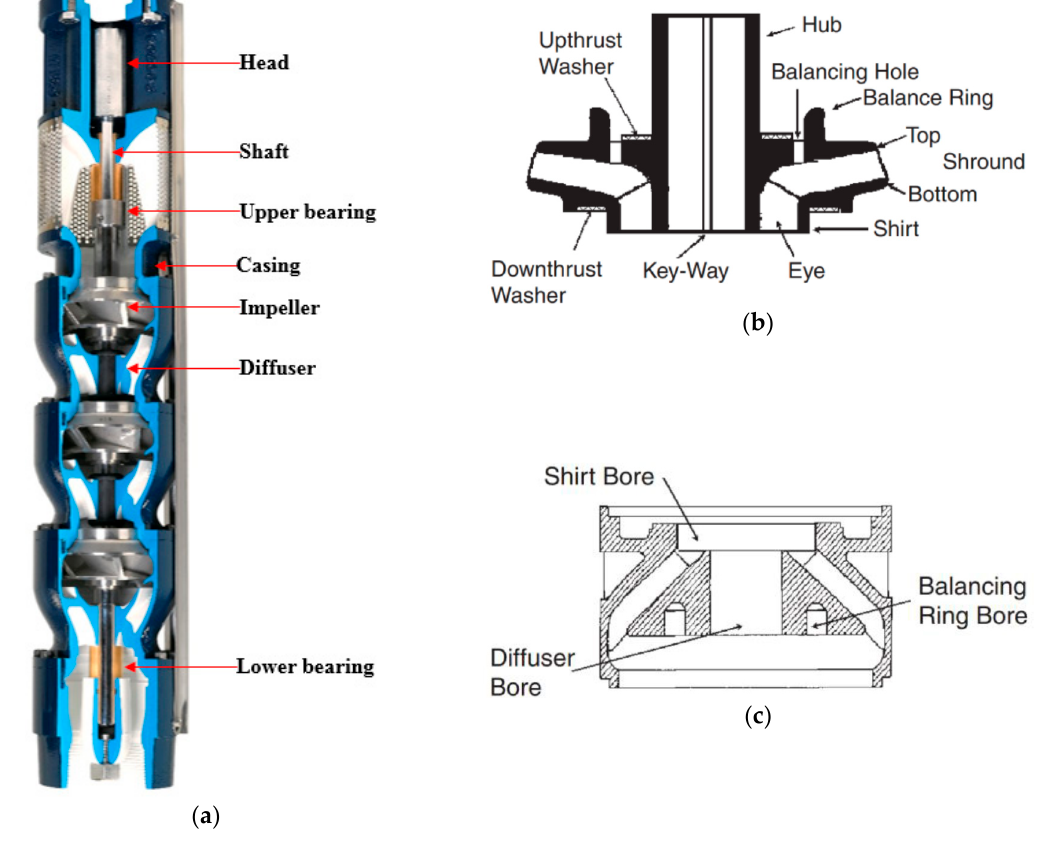
Figure 1. Main components of an electrical submersible pump (ESP). ( a ) Multistage assembly (figure courtesy of http://www.franklinwater.com); ( b ) impeller components; ( c ) diffuser components [3].